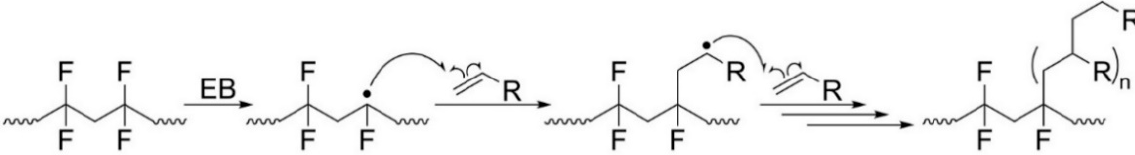
Figure 3. Conventional vinyl polymerization mechanism proposed in RIGP.